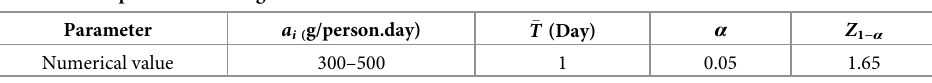
Table 1. Main parameter